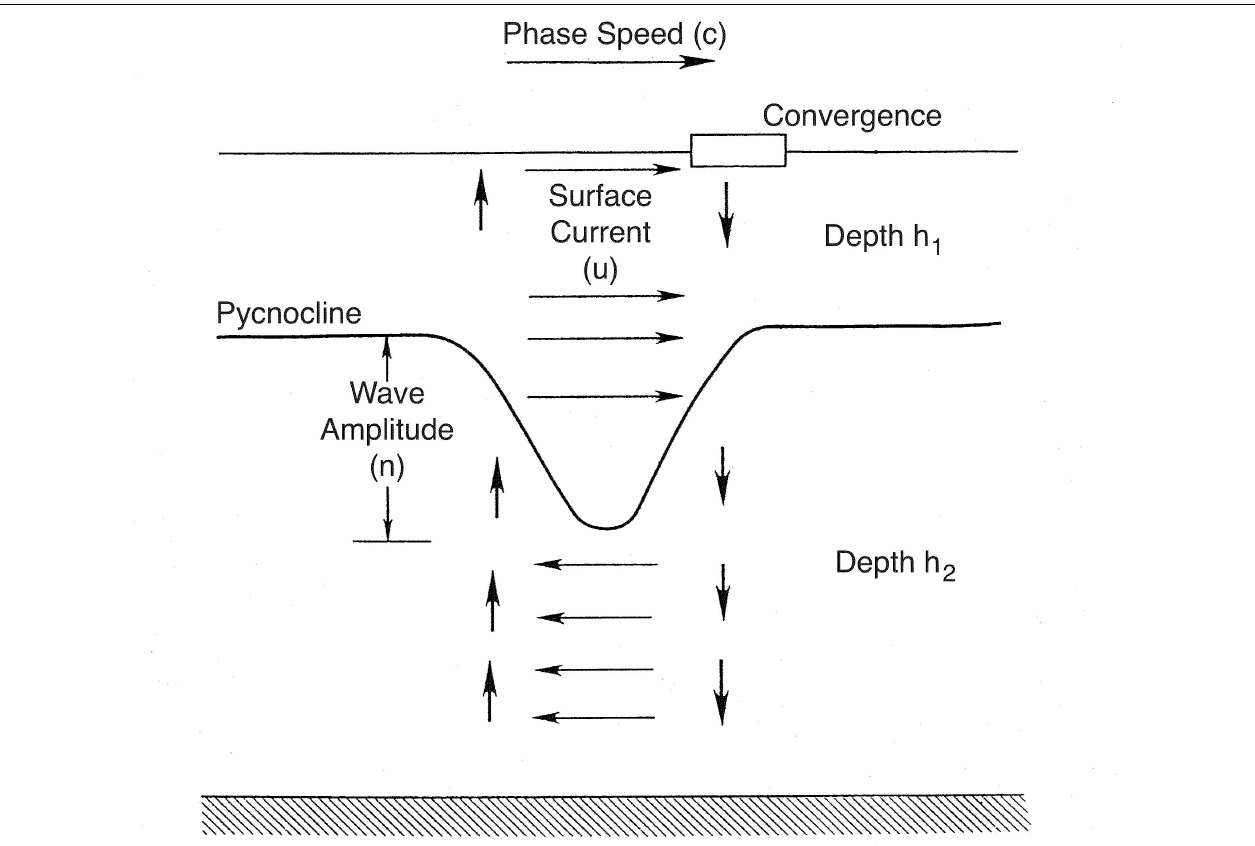
FIGURE 3 | Non-linear internal wave or soliton as a wave of depression on a pycnocline. Arrows indicate the direction of currents associated with the internal wave. Depths h 1 and h 2 are the distance from the surface to the undisturbed pycnocline and from there to the bottom, respectively. (c) and (u) are the phase speed of the internal wave and surface current speed above the soliton, respectively. (n) is the amplitude of the internal wave. Theoretically, transport within the convergence zone of floating debris or larvae/zooplankton swimming at the surface should occur when u ≥ c. Figure modified from that in Shanks (Shanks,